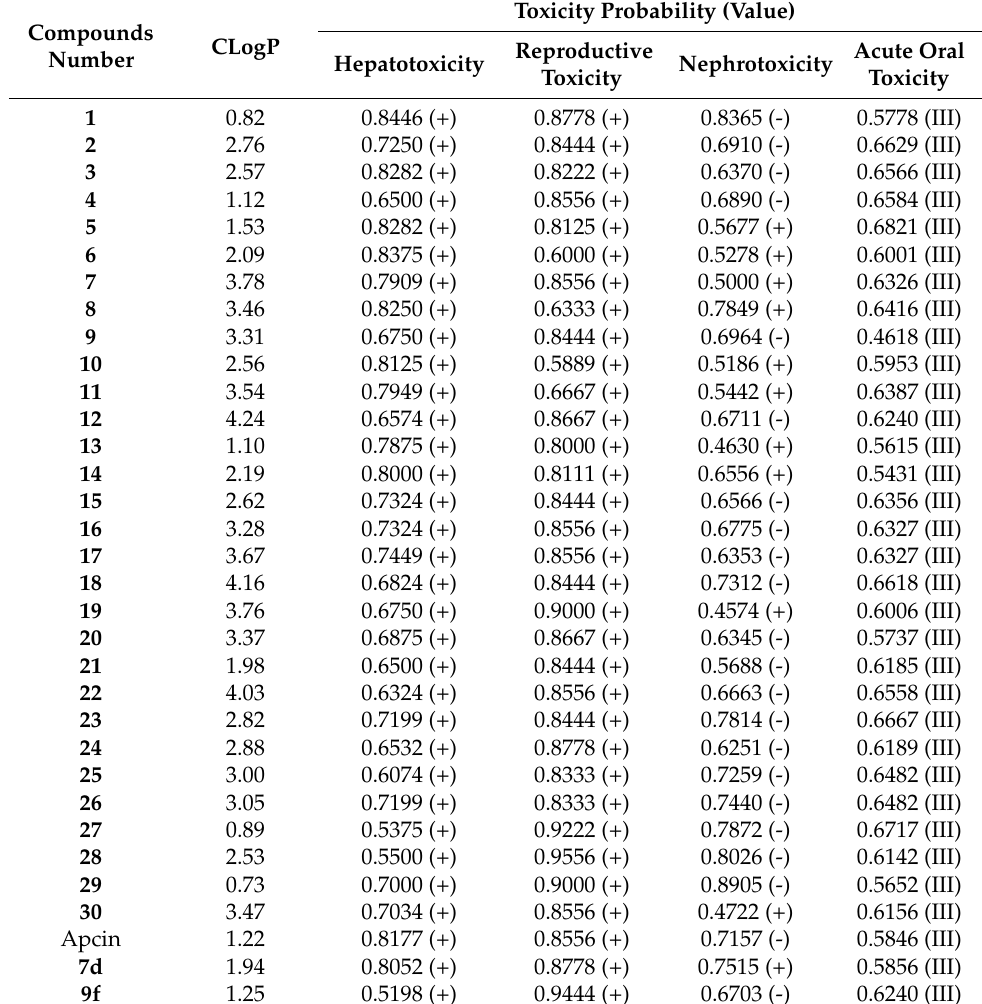
Table 3. LogP predictive value (cLogP) and toxicity predictive value of compounds